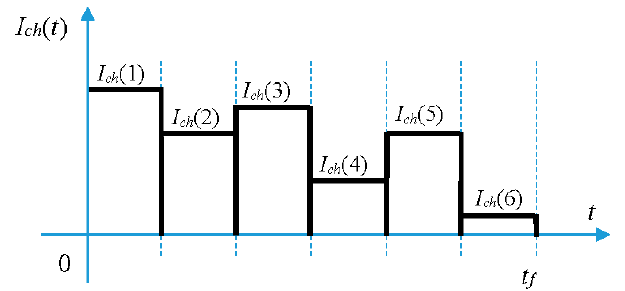
Figure 3. An example of a Multi-stage Constant Current (MCC) profile with 6 slots ( N = 6). Each value I ch (k) has to be optimised to find the current optimal profile.